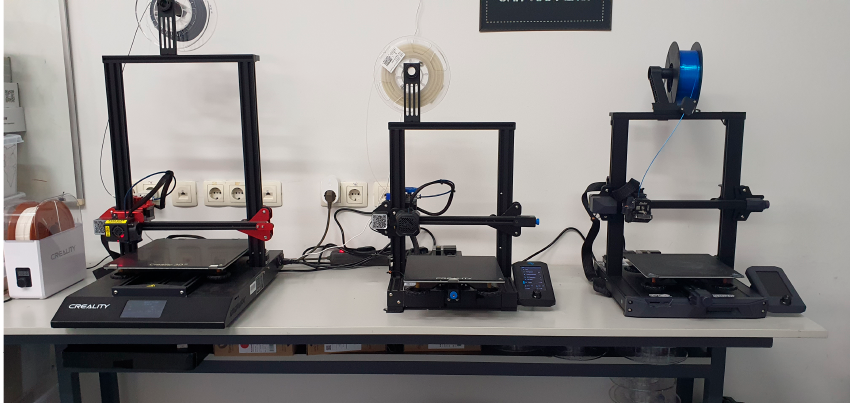
Figure 2. The applied Creality 3D printers.